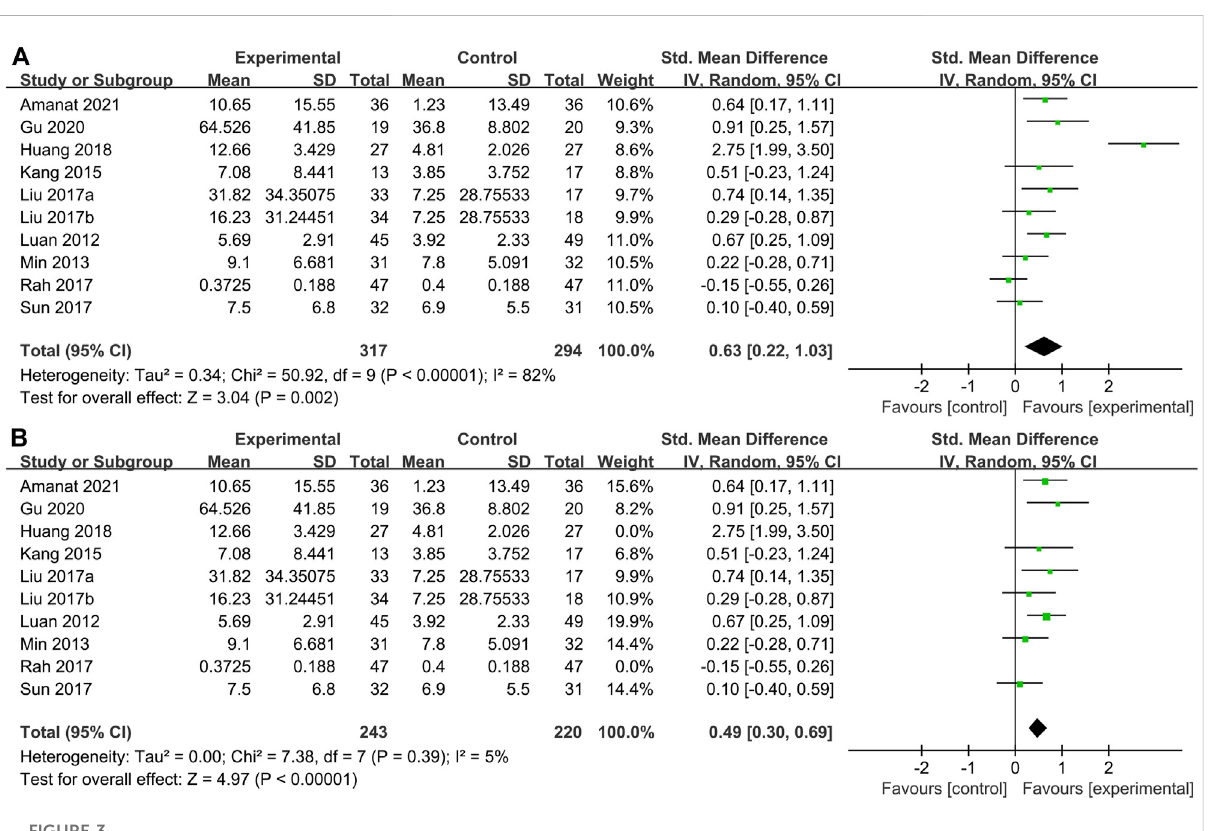
Primary indicators. Forest plot of GMFM. (A) Pooled results before sensitivity analysis. (B) Pooled results after eliminating heterogeneous